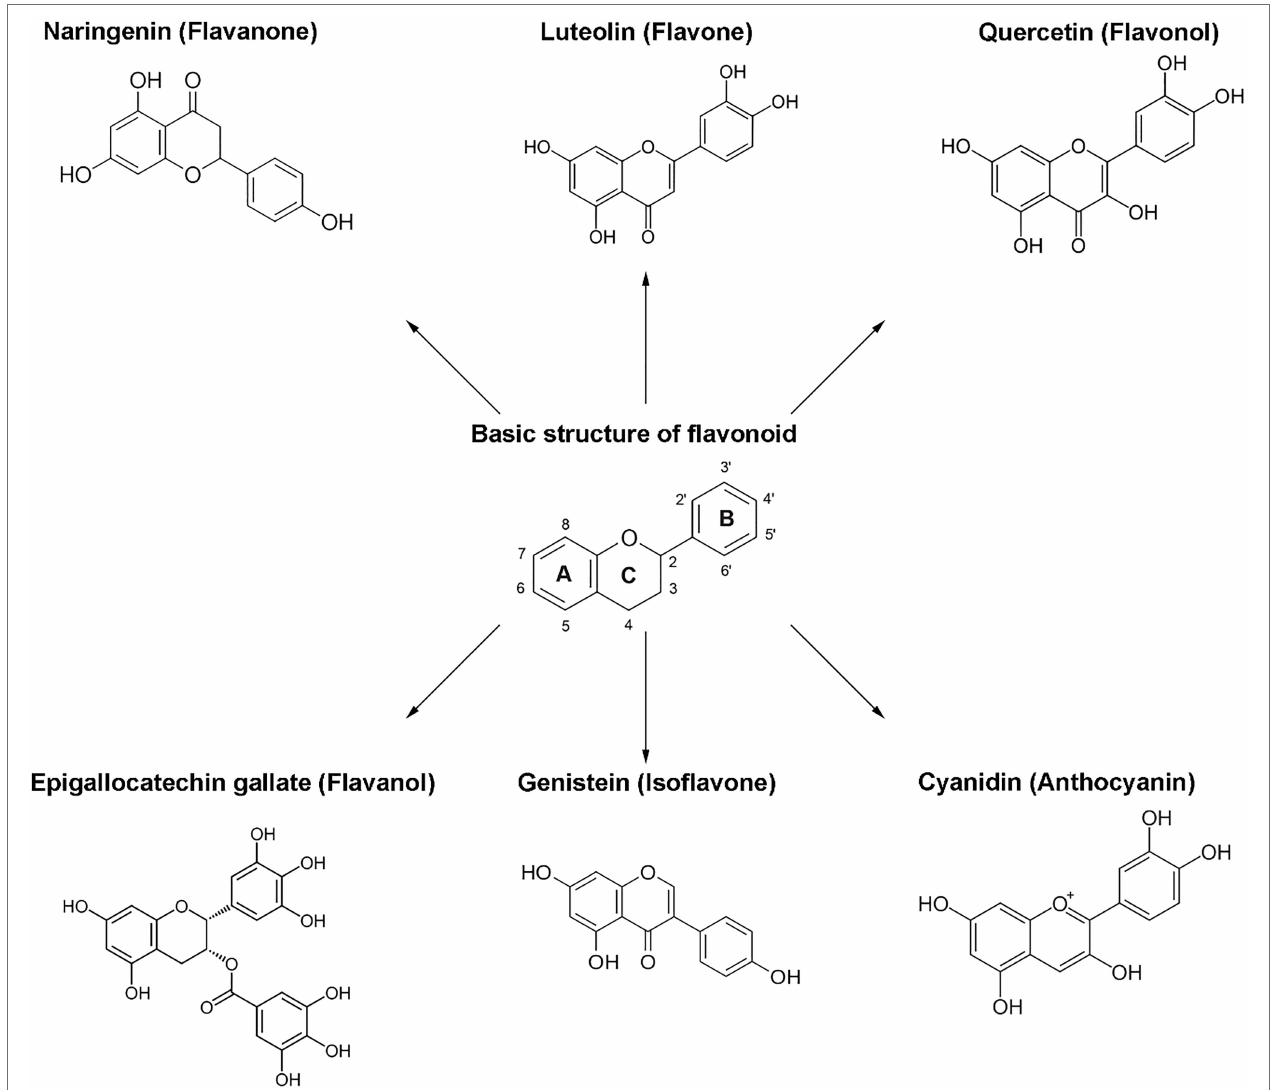
FIGURE 2 | Chemical structures of flavonoids and their subclasses. The basic flavonoid structure is presented in the center. The arrows illustrate examples of compounds for each flavonoid